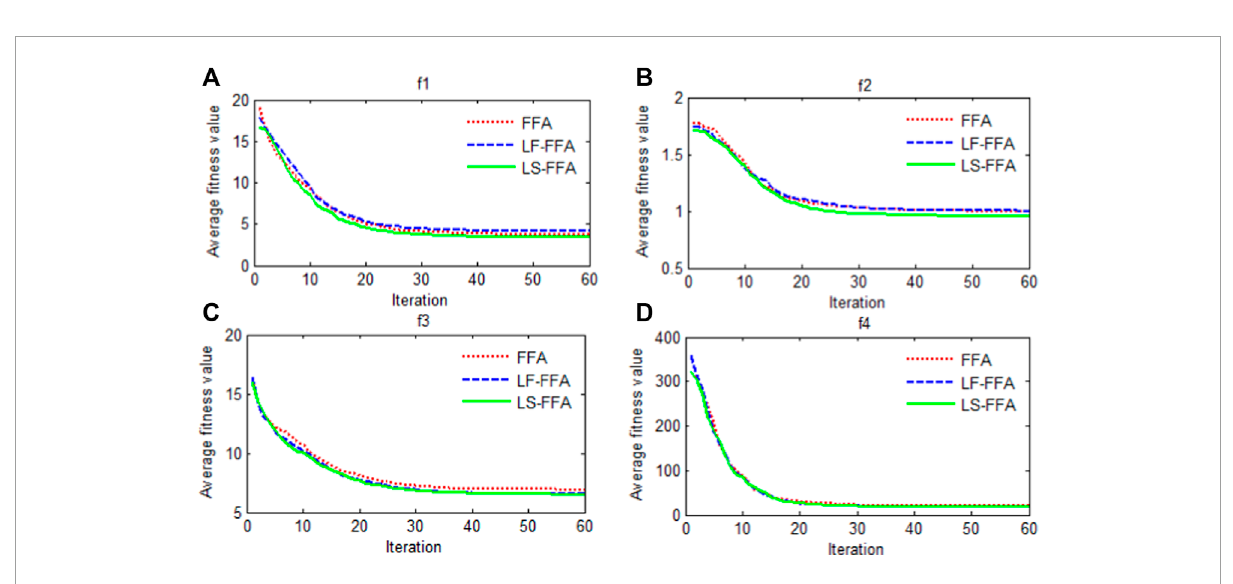
FIGURE 5 Trace of fitness for FA, LF-FA, and